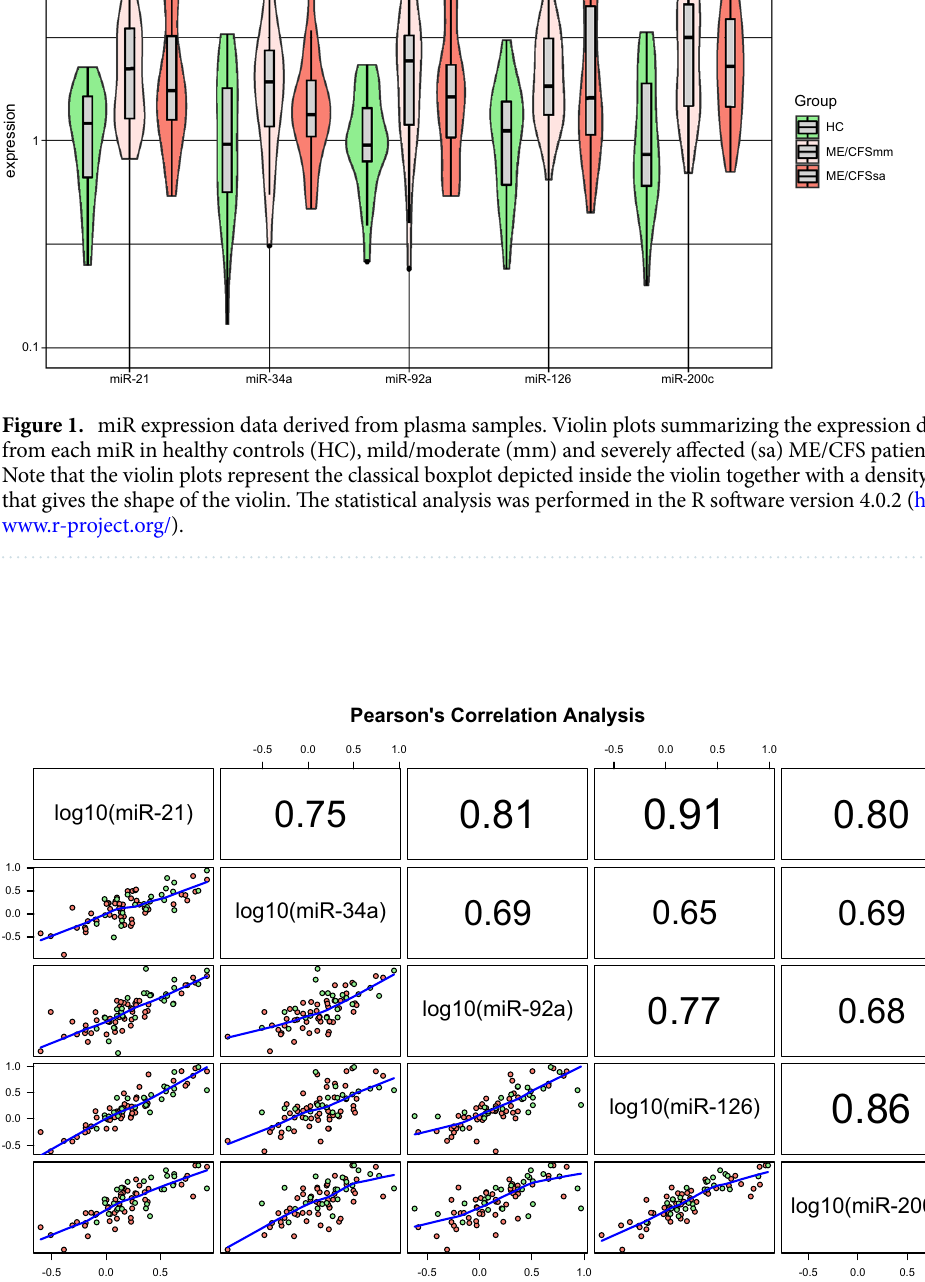
Figure 2. Correlation analysis between miRs expression data derived from plasma samples. Lower panel shows the scatterplots between the expression of a pair of miR taken in log10-scale where the blue line represents a lowess approximation of the respective relationship between x and y variables, and the dots in light green and salmon color represent healthy individuals and patients with ME/CFS, respectively. The values in upper panel are the Pearson´s correlation coefficient estimates for the corresponding data shown in lower panel. The statistical analysis was performed in the R software version 4.0.2 (https:// www.r- proje ct.